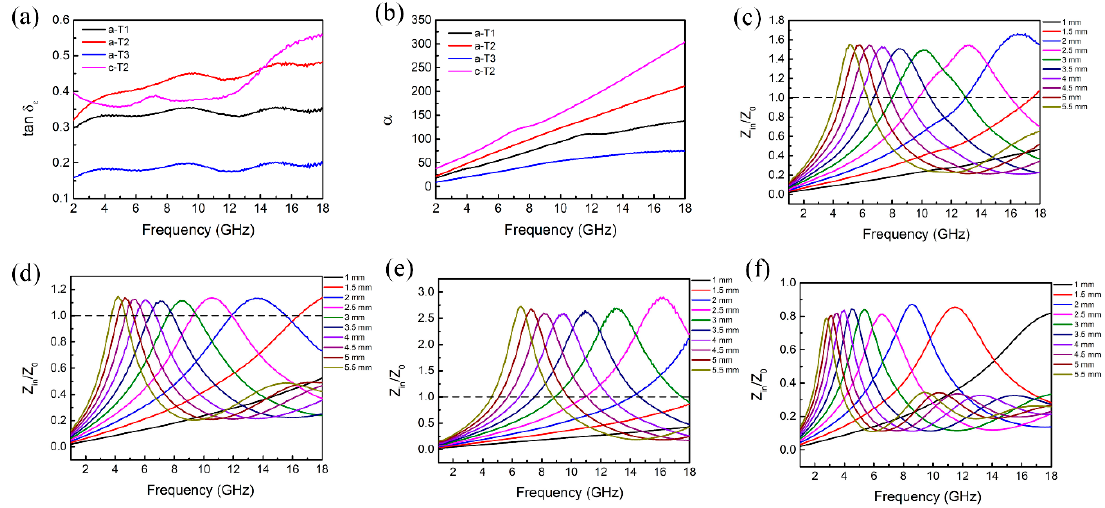
Figure 6. ( a ) Dielectric dissipation factor (tg δ ε ), ( b ) attenuation constant ( α ) of a-T1, a-T2, a-T3 and c-T2. Impedance matching (Z) with di ff erent thickness of ( c ) a-T1, ( d ) a-T2, ( e ) a-T3 and ( f ) c-T2 in the frequency range of 2-18 GHz.